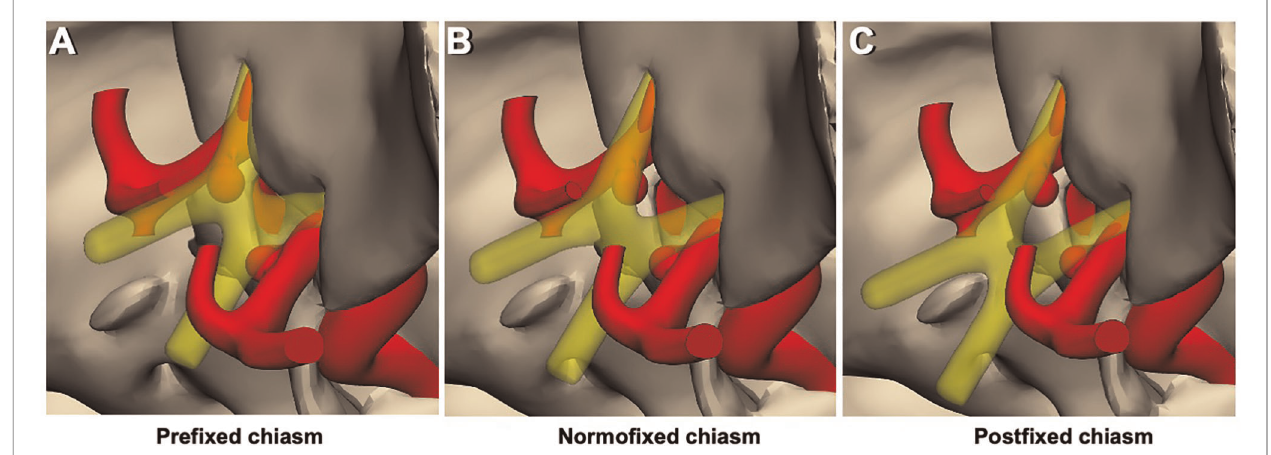
FIGURE 5 | 3D models of chiasm types and the relationship of the prechiasmatic area – aneurysms. ( A ) Pre fi xed chiasm type, regardless of its size and shape, the aneurysm remains below the optic chiasm. Consequently, there is not enough space for the contralateral approach. ( B ) Normo fi xed chiasm type provides suf fi cient space for the contralateral approach, depending on the shape and size of the aneurysm. ( C ) Post fi xed chiasm type provides suf fi cient space for the contralateral approach, more than the normo fi xed chiasm type, depending on the shape and size of the